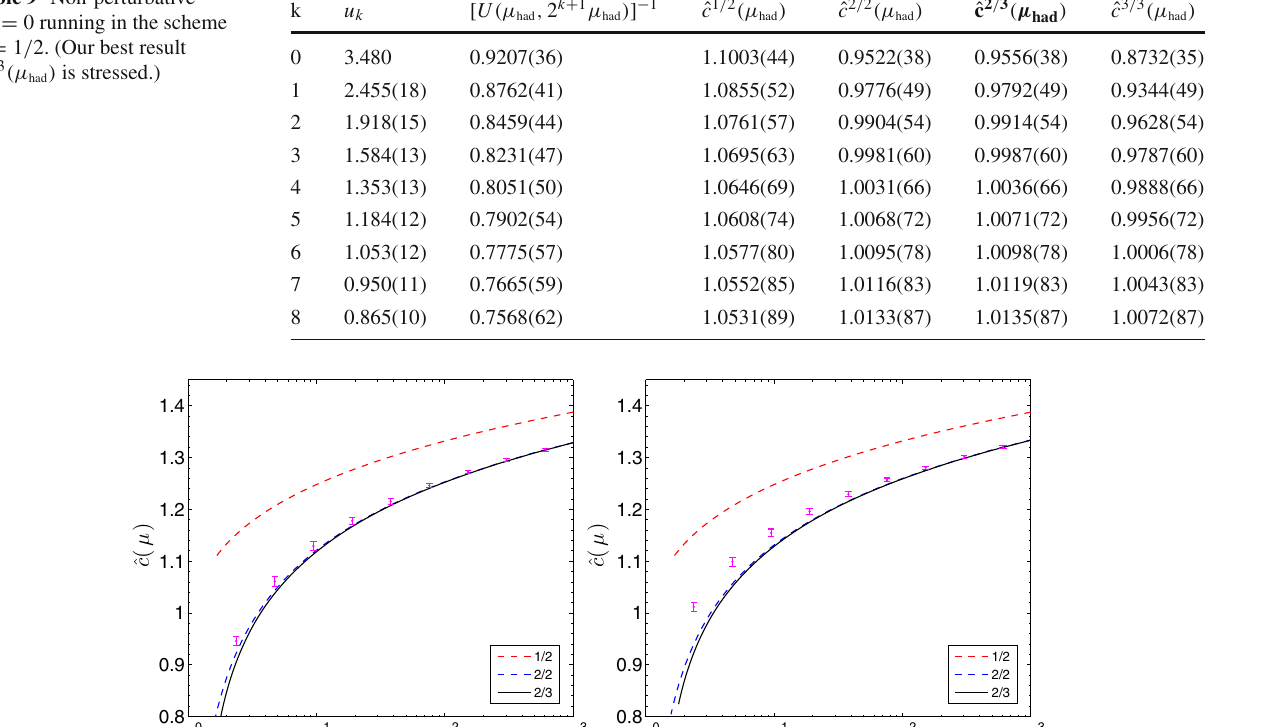
Table 9 Non-perturbative N f = 0 running in the scheme α = 1 / 2. (Our best result ˆ c 2 / 3 (μ ) is stressed.) had